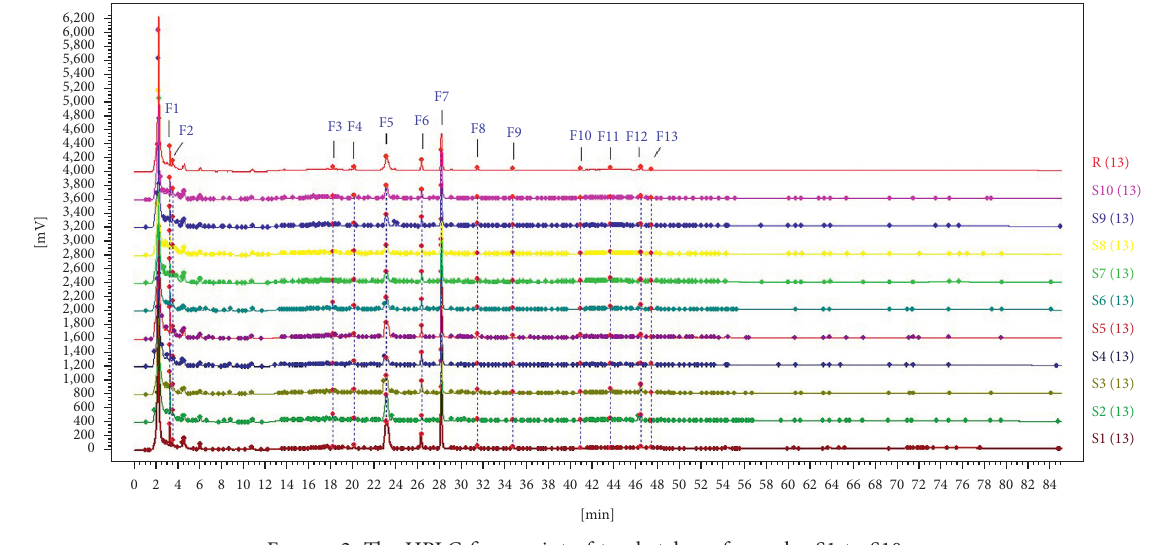
Figure 2: The HPLC fingerprint of ten batches of samples S1 to S10.